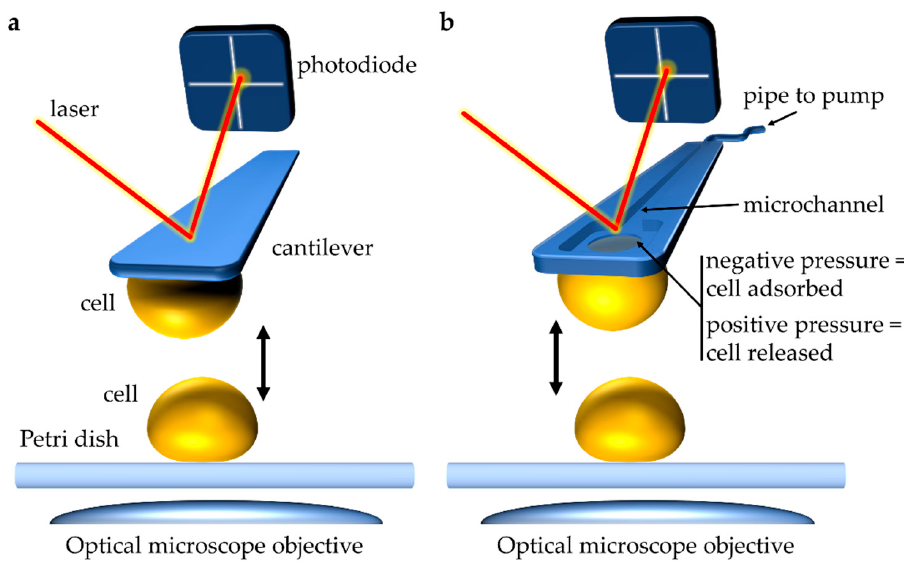
Figure 2. Atomic force microscopy (AFM) single-cell force spectroscopy (SCFS) to study cell–cell interactions during mating. ( a ) Conventional approach to performing single-cell SCFS experiments.